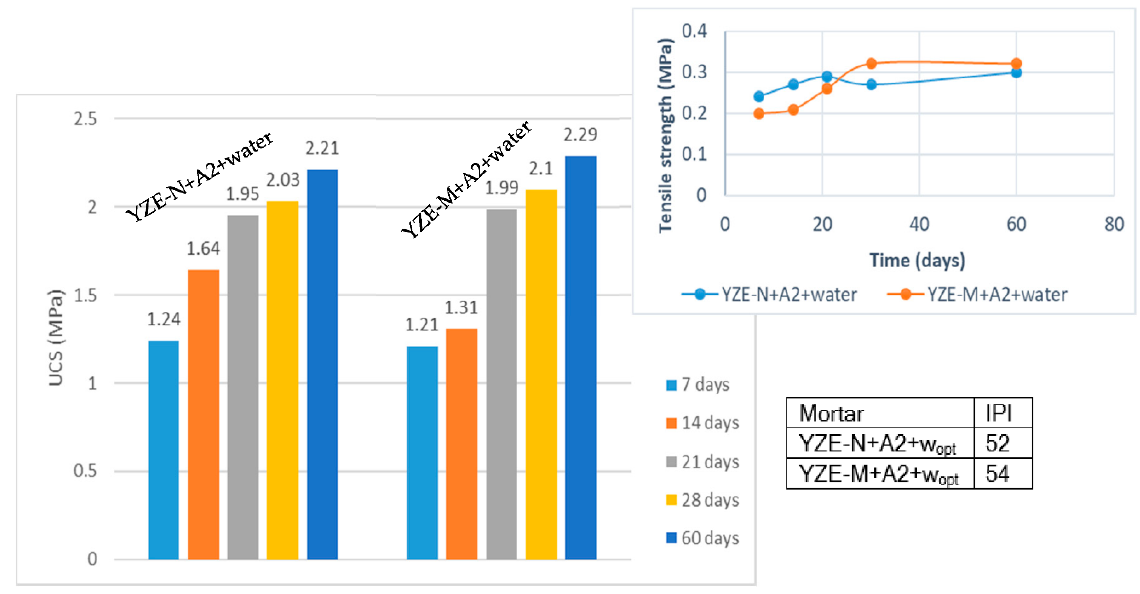
Figure 13. Comparison between NTC and MTC from Yzernay site.